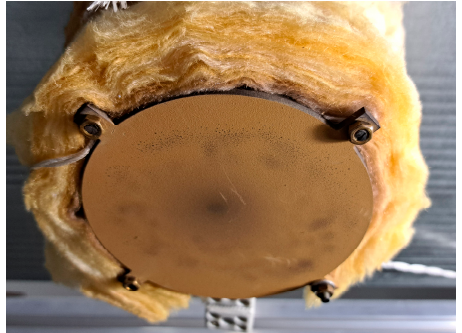
Figure 2. External view of the catalytic reactor.